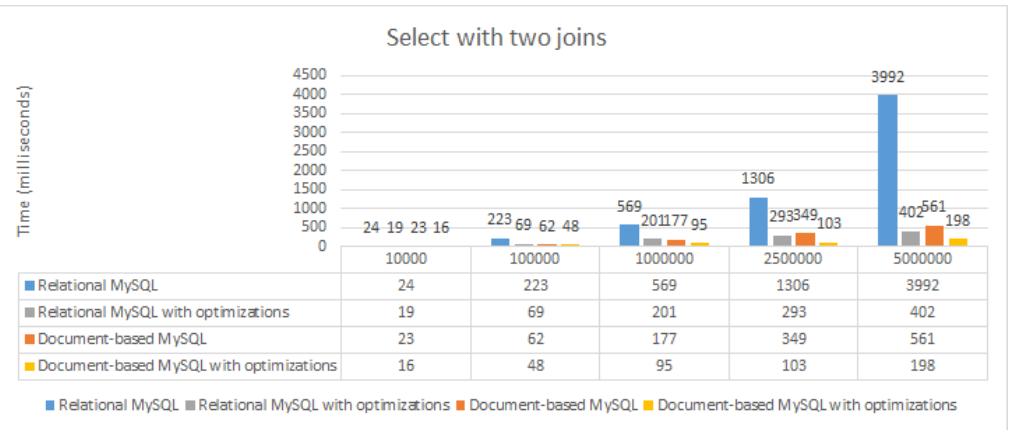
Figure 10. Performance time (ms) for the select operation with two joins.